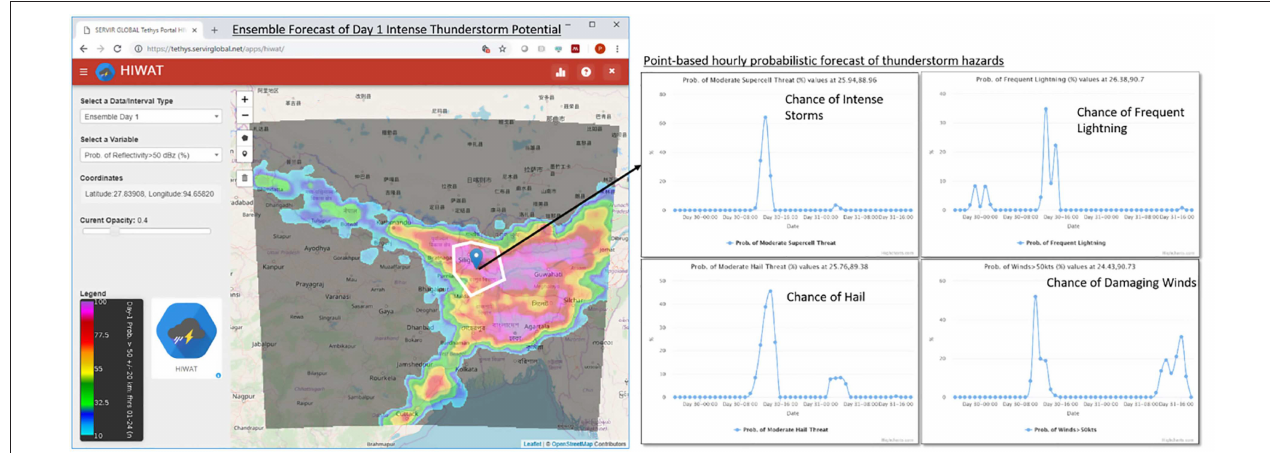
FIGURE 12 | Tethys-based application for HIWAT ensemble forecast weather hazards.